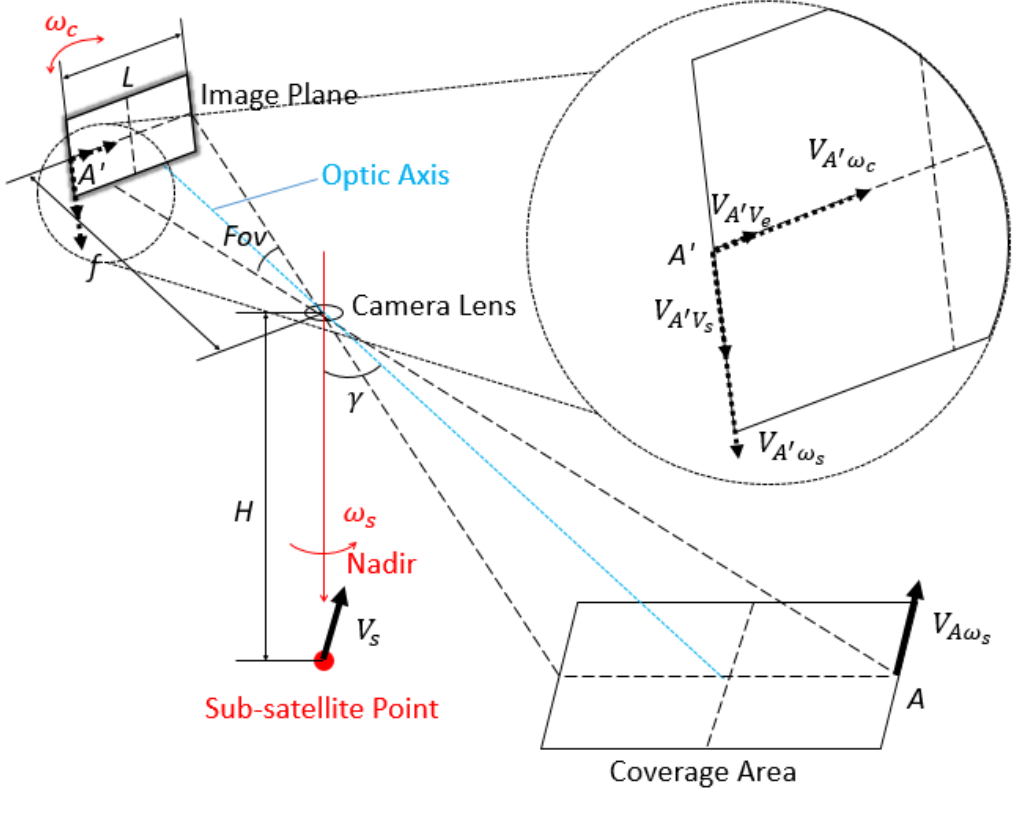
Figure 18. Image velocity analysis.